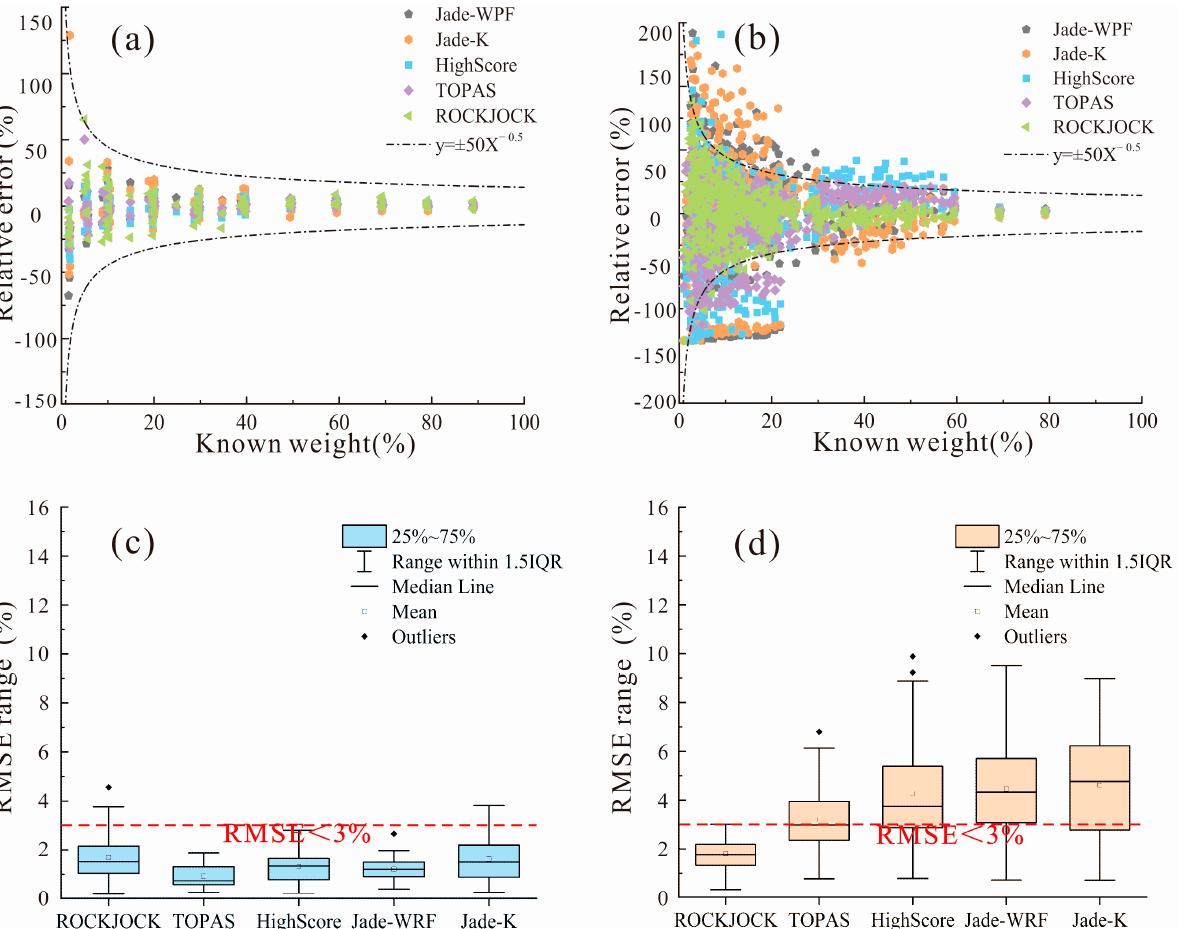
Figure 6. Scatter plot of the relative error ( ∆ RE ) of each phase and the root mean square error (RMSE) box pattern of each quantitative analysis method of sample. ( a , c ) are the mixture samples without clay minerals; ( b , d ) are the mixture samples containing clay minerals.